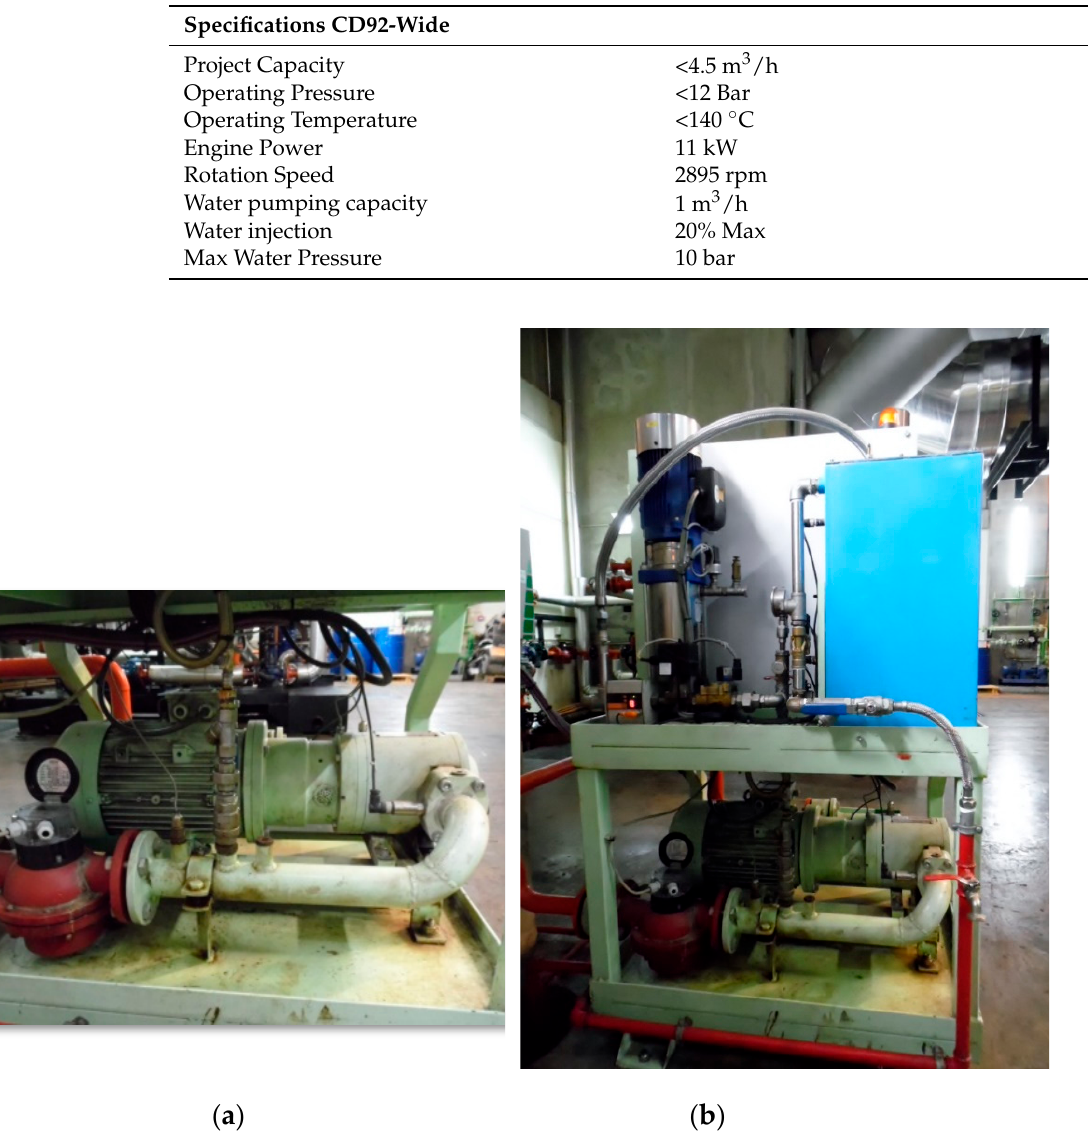
Table 3. Specification of S CD92-Wide system [53].